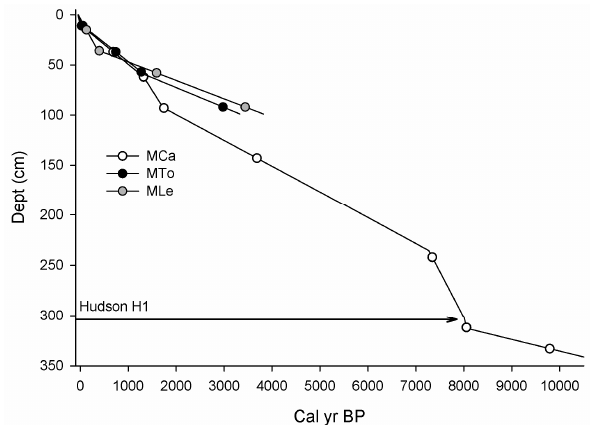
Fig. 3. Linear age-depth model for the composite charcoal records of the calibrated radiocarbon dates. 14 C dating errors range is ± 15– 25yr and is imperceptible at this age-scale resolution. The arrow indicates the position of the Hudson Vn. H1 tephra found in the mall´ın Casanova (MCa; see also Fig. 2a). MTo and MLe stand for mallines Tortel and